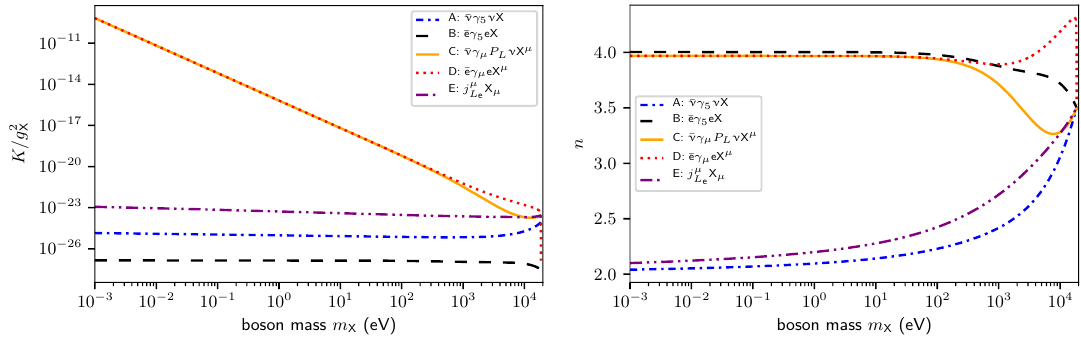
Figure 2 . Parameters for the spectrum approximation of eq. (A.15) for various coupling structures.